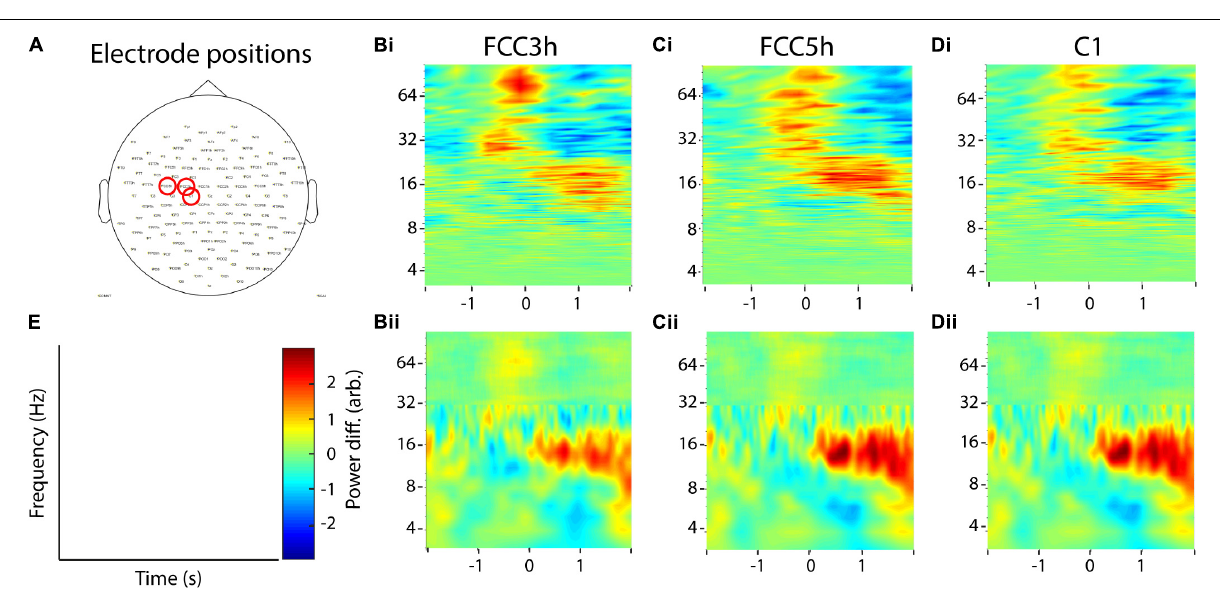
narrowband oscillations (Leszczy´nski et al., 2020).